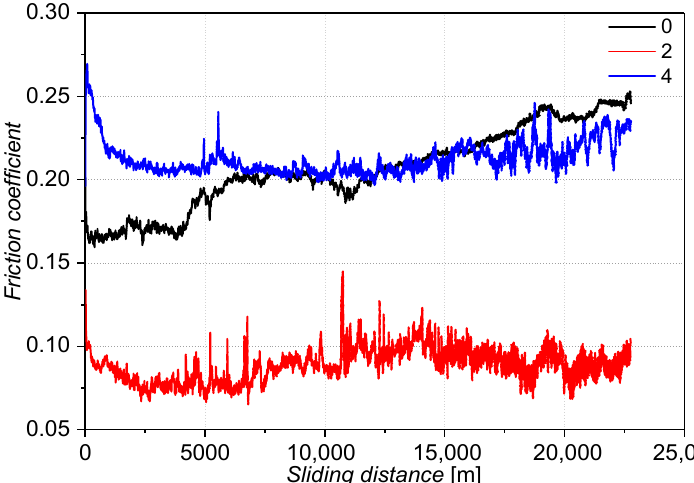
Figure 10. Coe ffi cient of friction of the tested alloys by the pin-on-disc method. Figure 10. Coefficient of friction of the tested alloys by the pin-on-disc method.